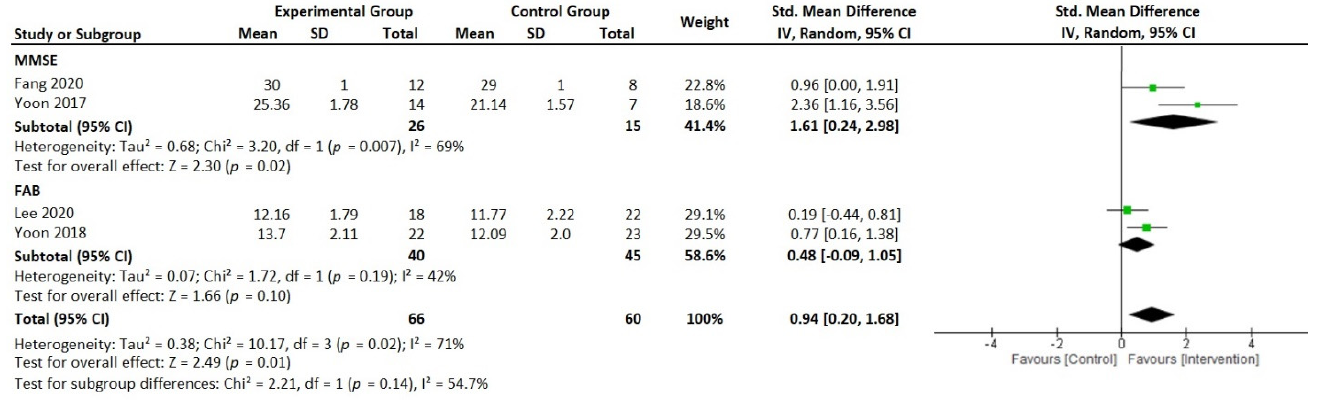
Figure 2. Forest plot presenting standardized mean difference and 95% confidence intervals from studies reporting high-speed resistance-training-induced changes in cognitive function between the intervention groups and the control groups. IV, independent variable; CI, confidence interval; SMD, standardized mean difference; FAB, frontal assessment battery; MMSE, mini-mental state examination [60,63,66,67].